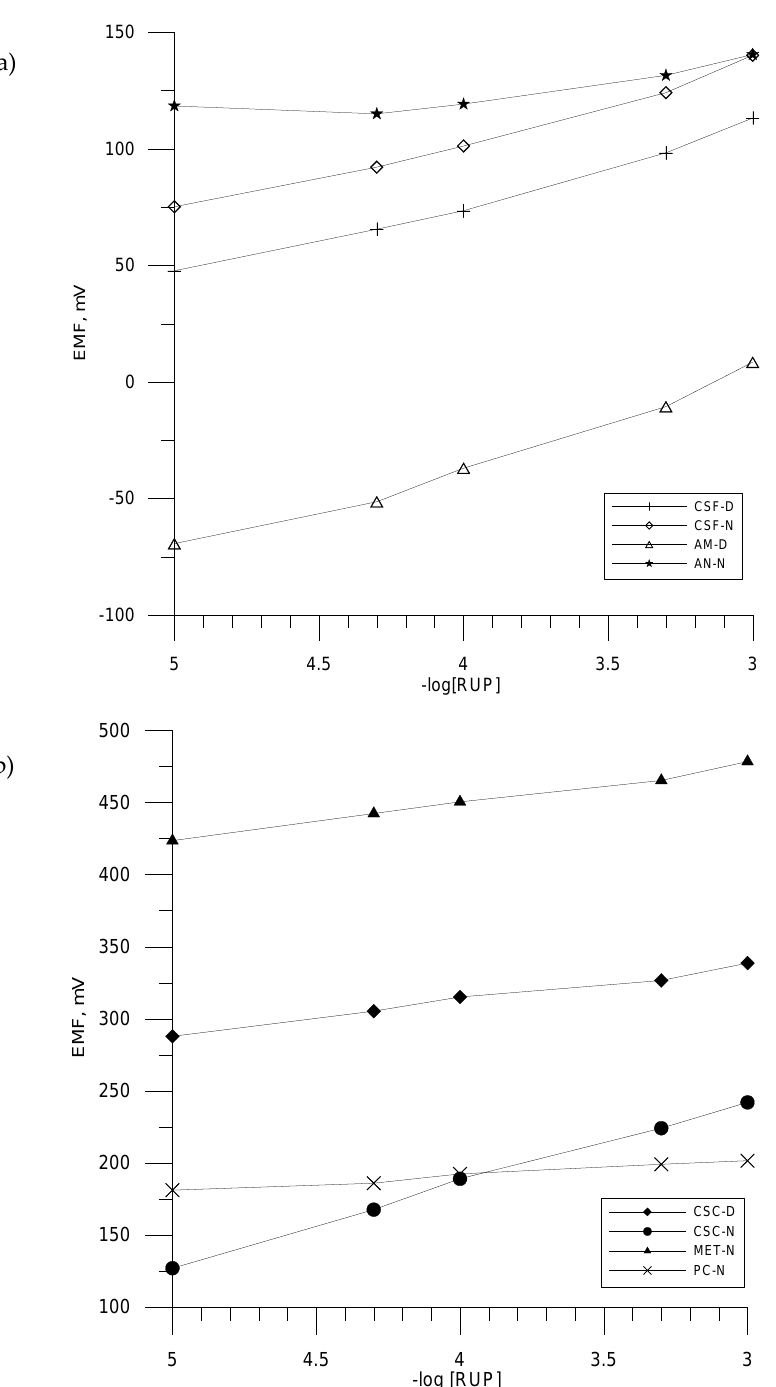
Figure 7. PC2, calibration curves of ion-selective electrodes with CSF, AM, AN ( a ) and CSC, MET, PC ( b ) in 10 −5 –10 −3 mol L −1 RUP solutions.